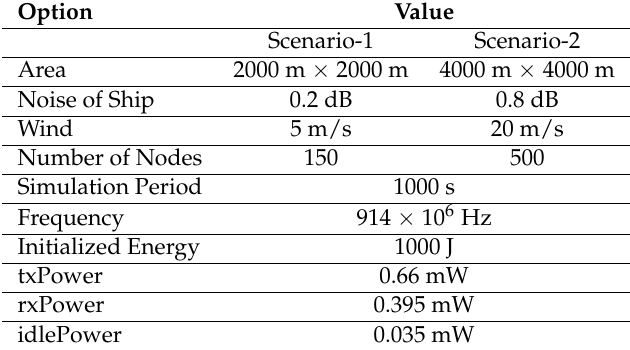
Table 4. Simulation